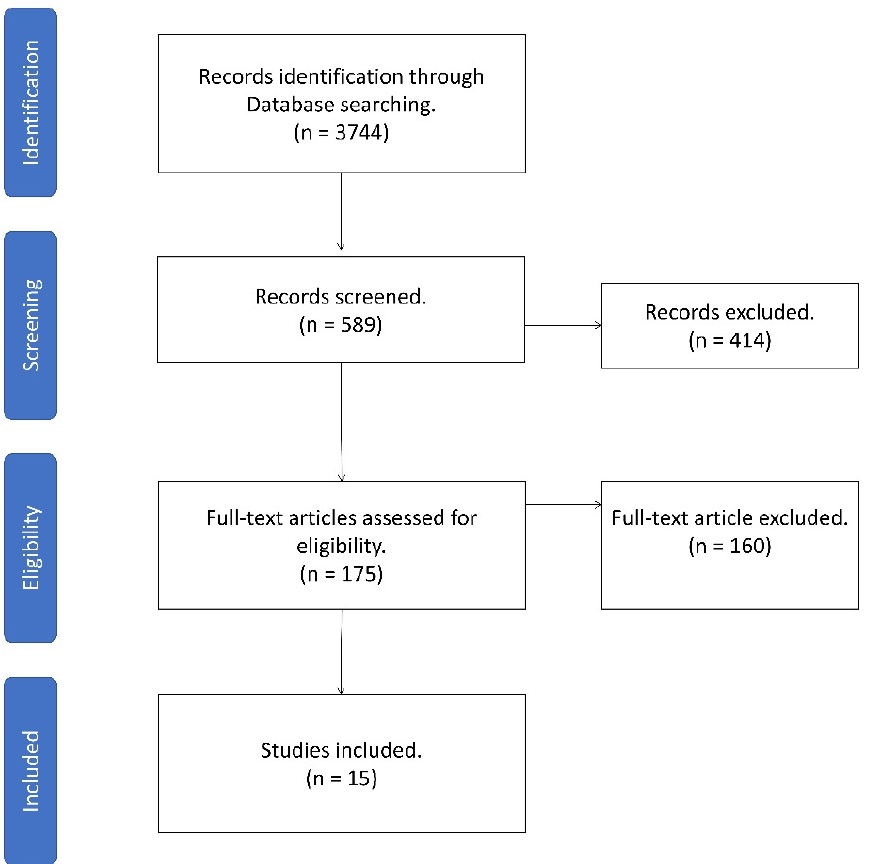
Figure 1. Flowchart of the study screening process for original studies in neutrophils for the ocular surface.